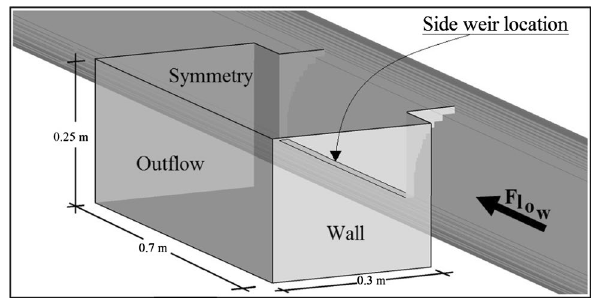
Fig. 1 Defined boundary conditions for connected tank to side weir in numerical model